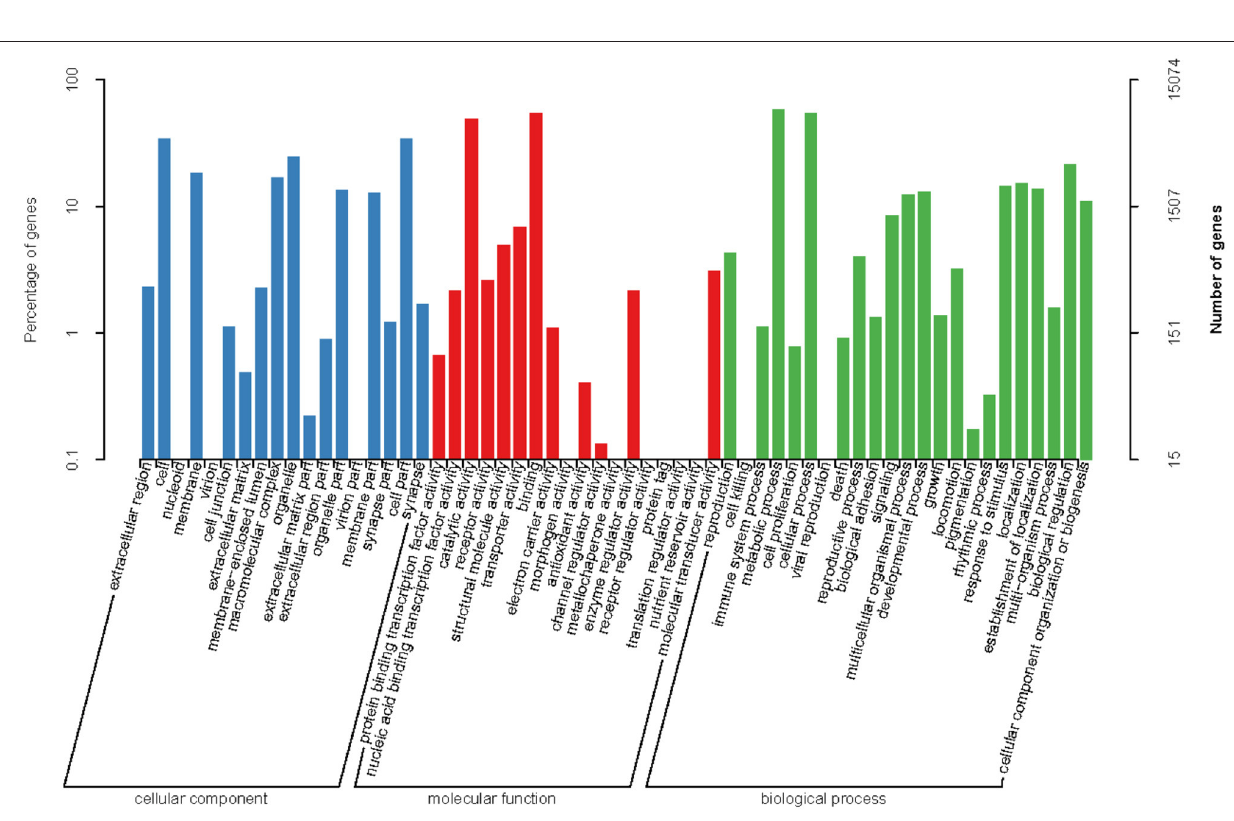
Frontiers in Physiology |